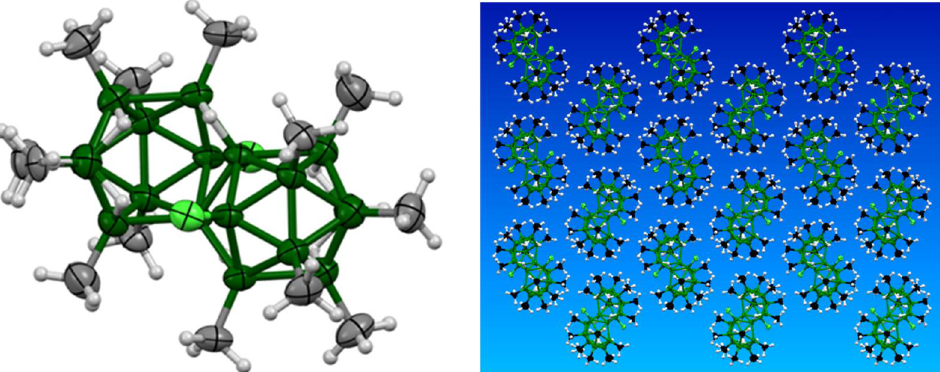
Figure 10. The molecular structure of anti -B 18 H 7 Cl 2 Me 13 containing 13 peripheral methyl groups and two chlorine atoms [29]. The right view shows the crystal packing for the molecule and emphasizes the potentially protective sheath of methyl groups around the boron core (green atoms).